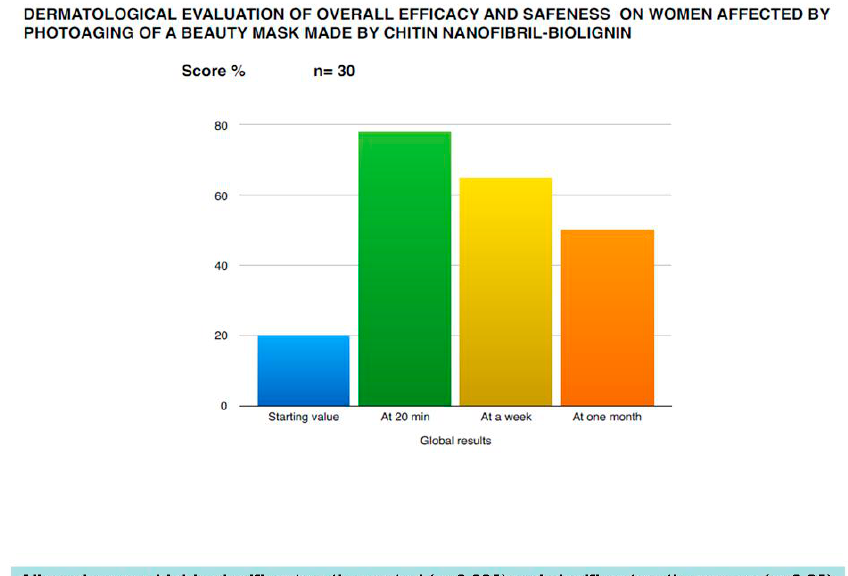
Figure 12. Dermatological subjective evaluation of the mask on the skin rejuvenation of photoaged women.